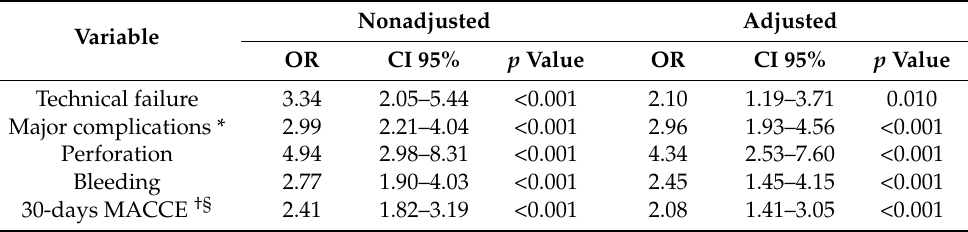
Table 5. Multivariate analysis between secondary endpoints (technical success, major complica- tions, perforation, bleeding, 30-days MACE) and prolonged nonocclusive (non-CTO) percutaneous coronary intervention (PCI) according to the predefined cut-off minute value (<21.1 min). Nonadjusted Variable OR CI